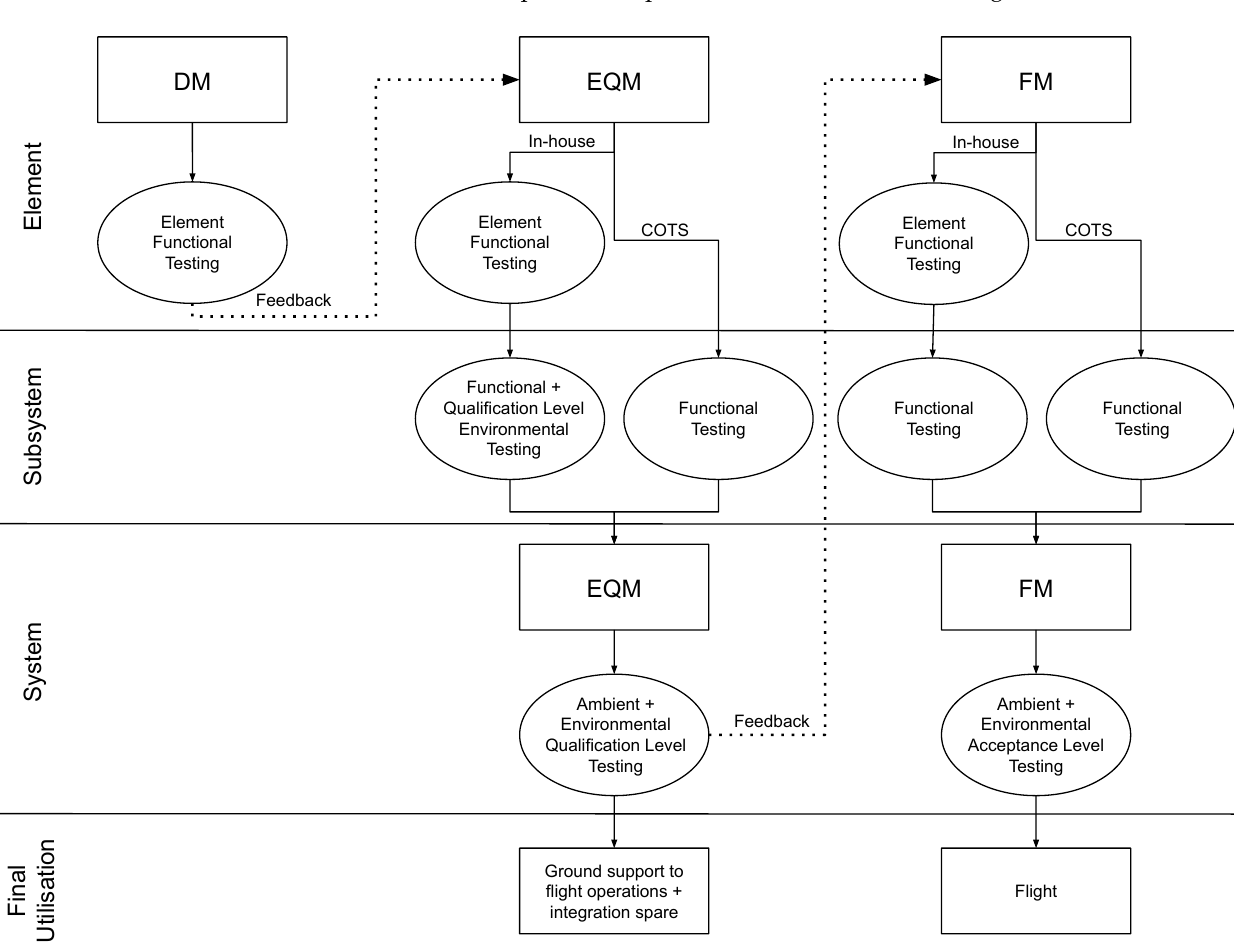
Figure 2. Prototype model philosophy employed by EIRSAT-1 showing the test activities for element, subsystem, and system level for both the engineering qualification model (EQM) and flight model (FM). Once complete, the EQM acts as an integration spare and an on-ground debugging tool to support flight operations of the FM. The EQM is tested to qualification levels while the FM is tested to acceptance levels. No environmental test campaign is performed on the in-house developed subsystems for